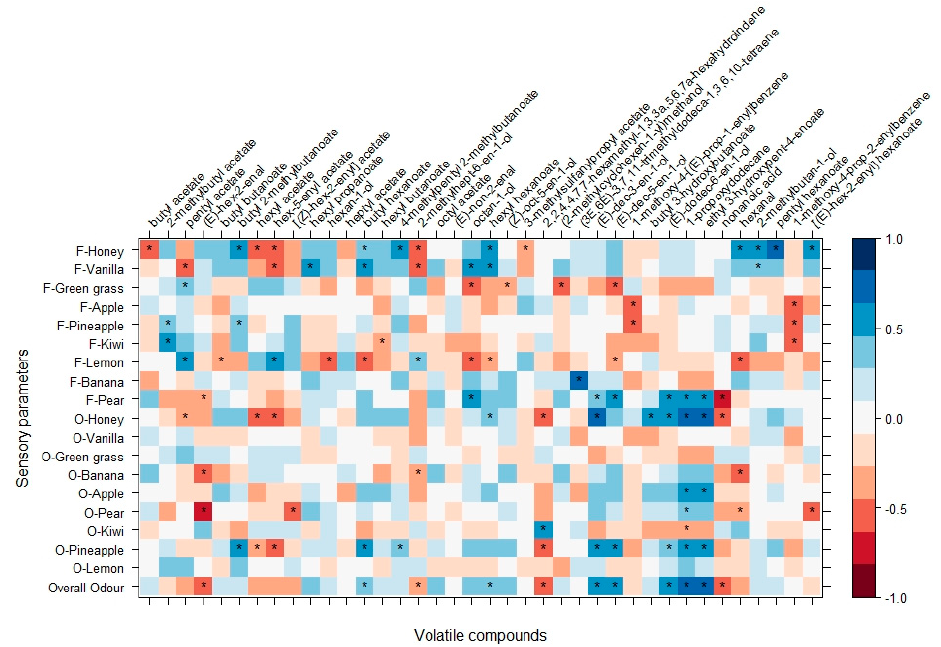
Figure 3. Correlation matrix. Sensory parameters and volatile organic compounds are reported as results of cross correlation analysis. Red colored squares indicate negative correlations, while blue colored squares indicate positive correlation. The significative correlations with a p value < 0.05 are reported with asterisks.